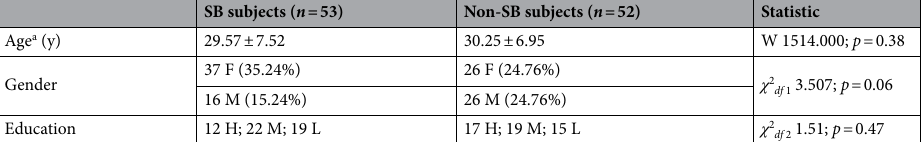
Table 1. Group differences in sociodemographic data ( n = 105). a Descriptive data is presented as M ± SD; Y